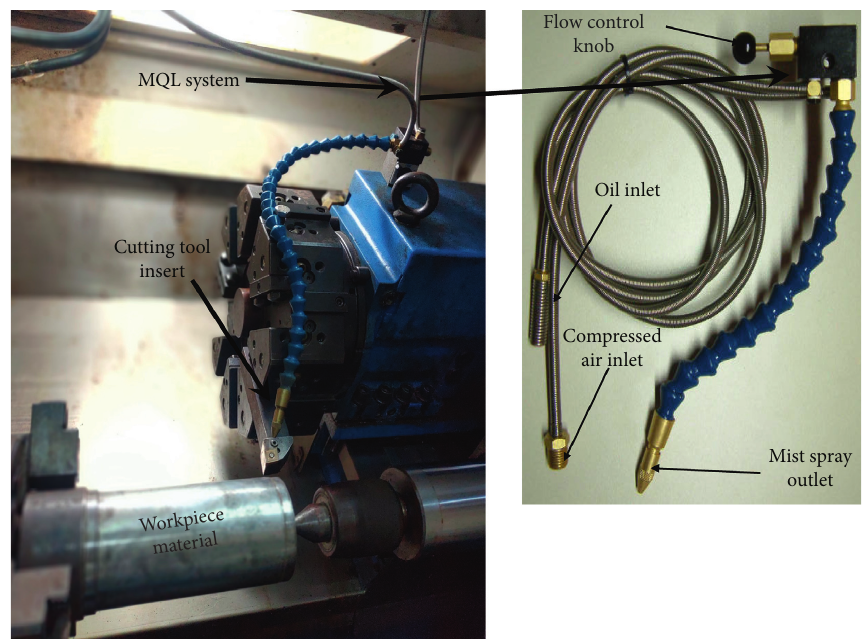
Figure 3: Experimental setup of Hybrid NF-MQCL/MQCL